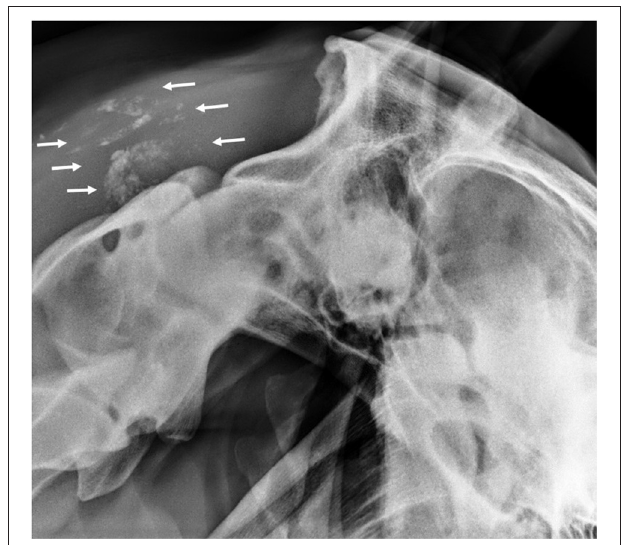
FIGURE 1 | Lateral radiograph of the atlanto-occipital joint showing mineralization in the region of the nuchal bursa (arrows).